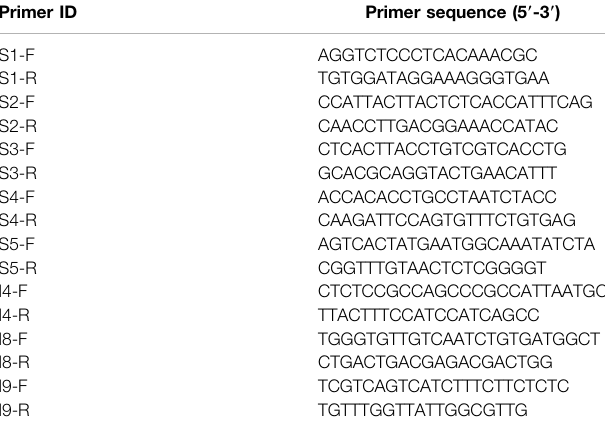
TABLE 1 | Primers used in this study.